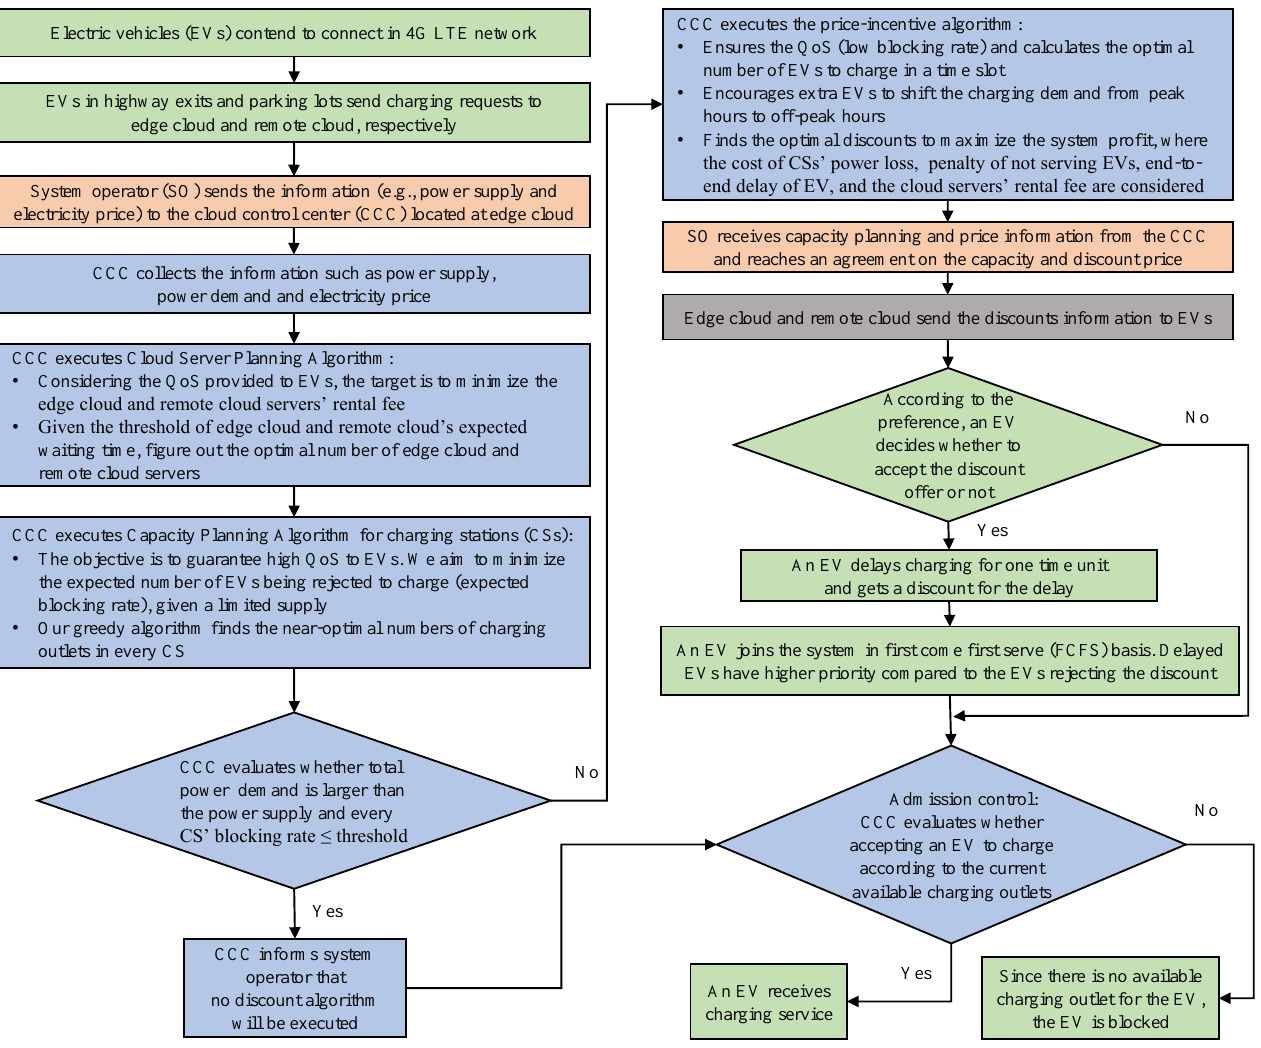
Figure 3. Proposed approach for cloud-based EV charging in IoV: Functionality and interactions among